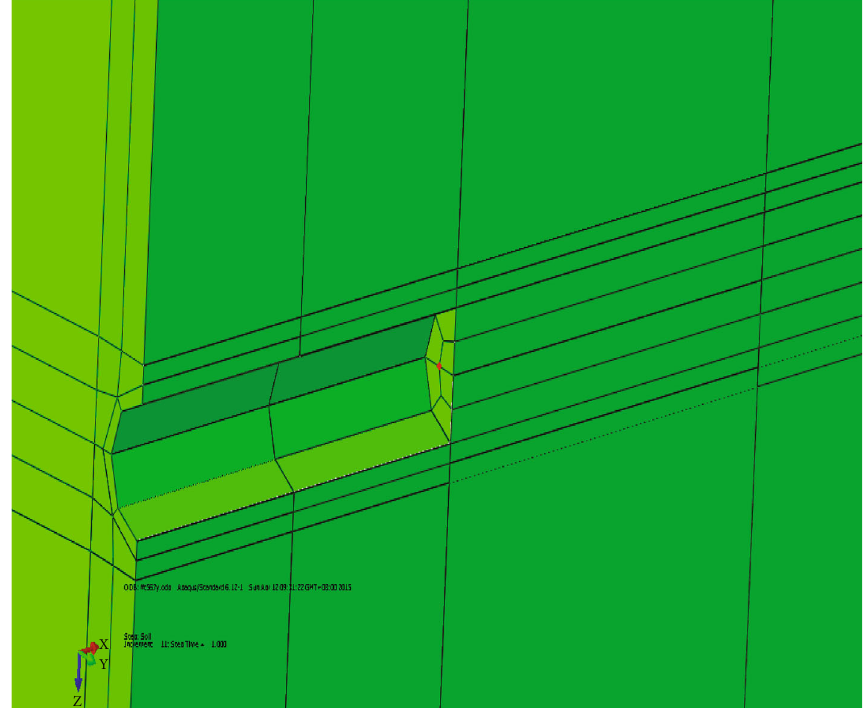
Figure 9: Location of test